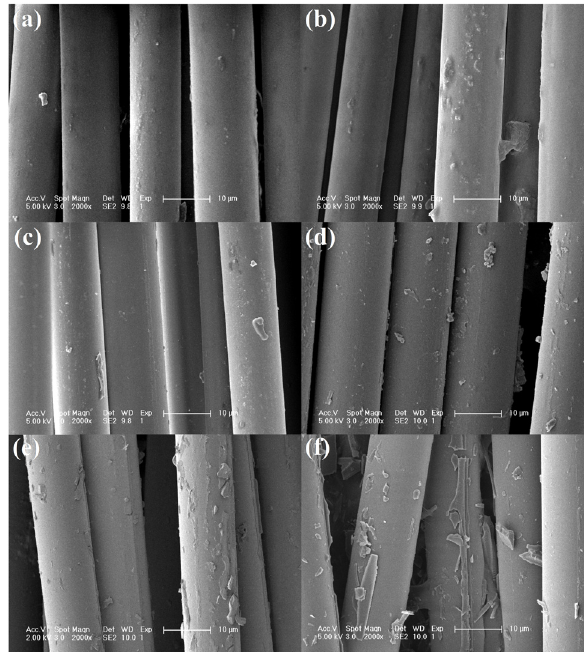
Figure 4: SEM micrographs of ( a ) U - BF, ( b ) C - BF, ( c ) K0.5 - BF, ( d ) K1.0 - BF, ( e ) K1.5 - BF, and ( f ) K2.0 - BF.